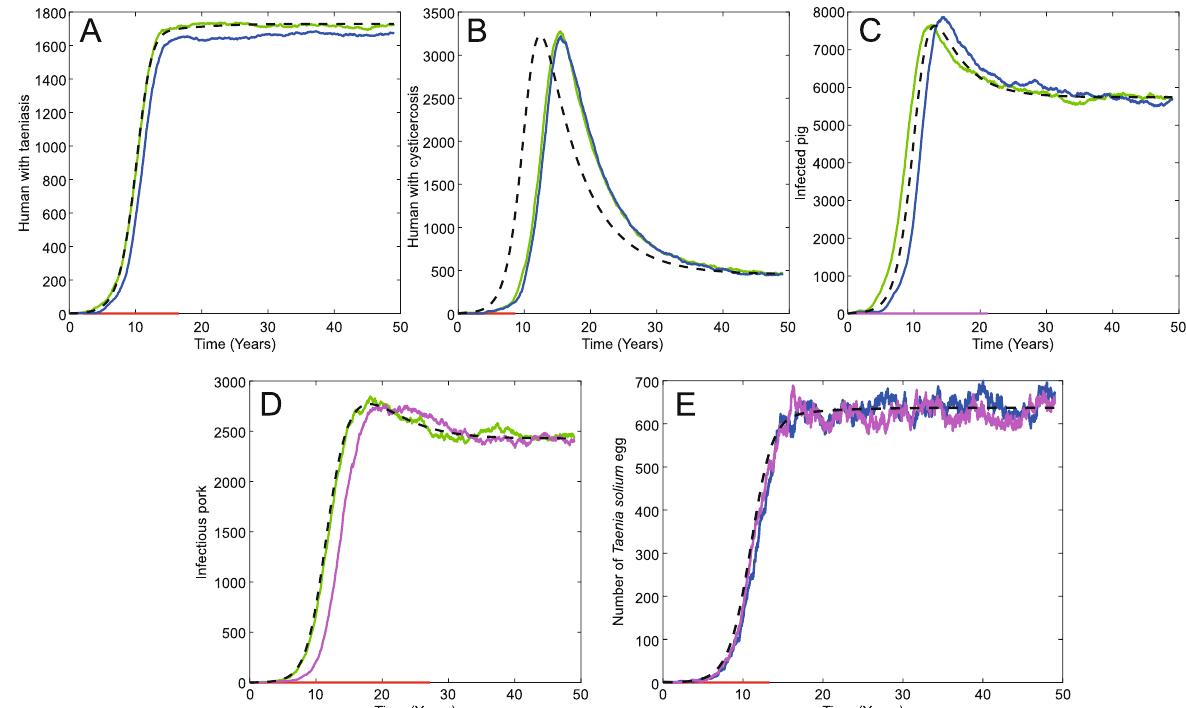
Fig. 8 Comparison of deterministic solution (dashed) and three sample paths of the CTMC (solid) for infected human, infected pig and infectious pork. A . Human with taeniasis; B . Human with cysticercosis; C . Infected pig; D . Infectious pork; E . Number of Taenia solium